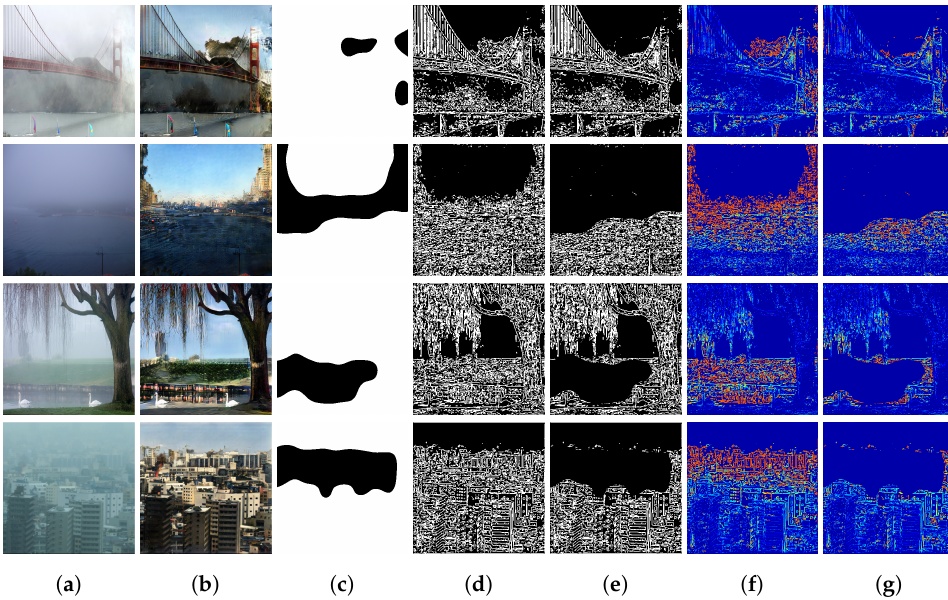
Figure 6. Benefits of HArD + e and HArD + ¯ r over the simple indicators e and ¯ r . ( a ) Real foggy images, ( b ) defogged images with various level of artifacts, ( c ) the binarized mask obtained from the HArD metric, ( d ) the visible edges in the defogged image. Note the high number of edges in regions where artifacts are present. ( e ) Visible edges used to compute HArD + e and HArD + ¯ r ; note that edges belonging to artifacts are not considered. ( f ) The ratio of the gradients between the defogged and the foggy images. Note the high value in regions where artifacts are massively present (bright red indicates a ratio greater than 10). ( g ) The ratio used to calculate HArD+ ¯ r . Note the near-absence of regions with a saturated gradient. Images are better viewed if enlarged on a computer